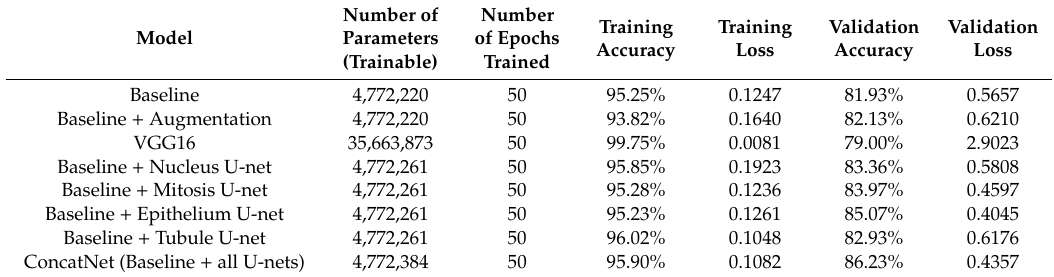
Table 2. Results on the training and validation sets for models